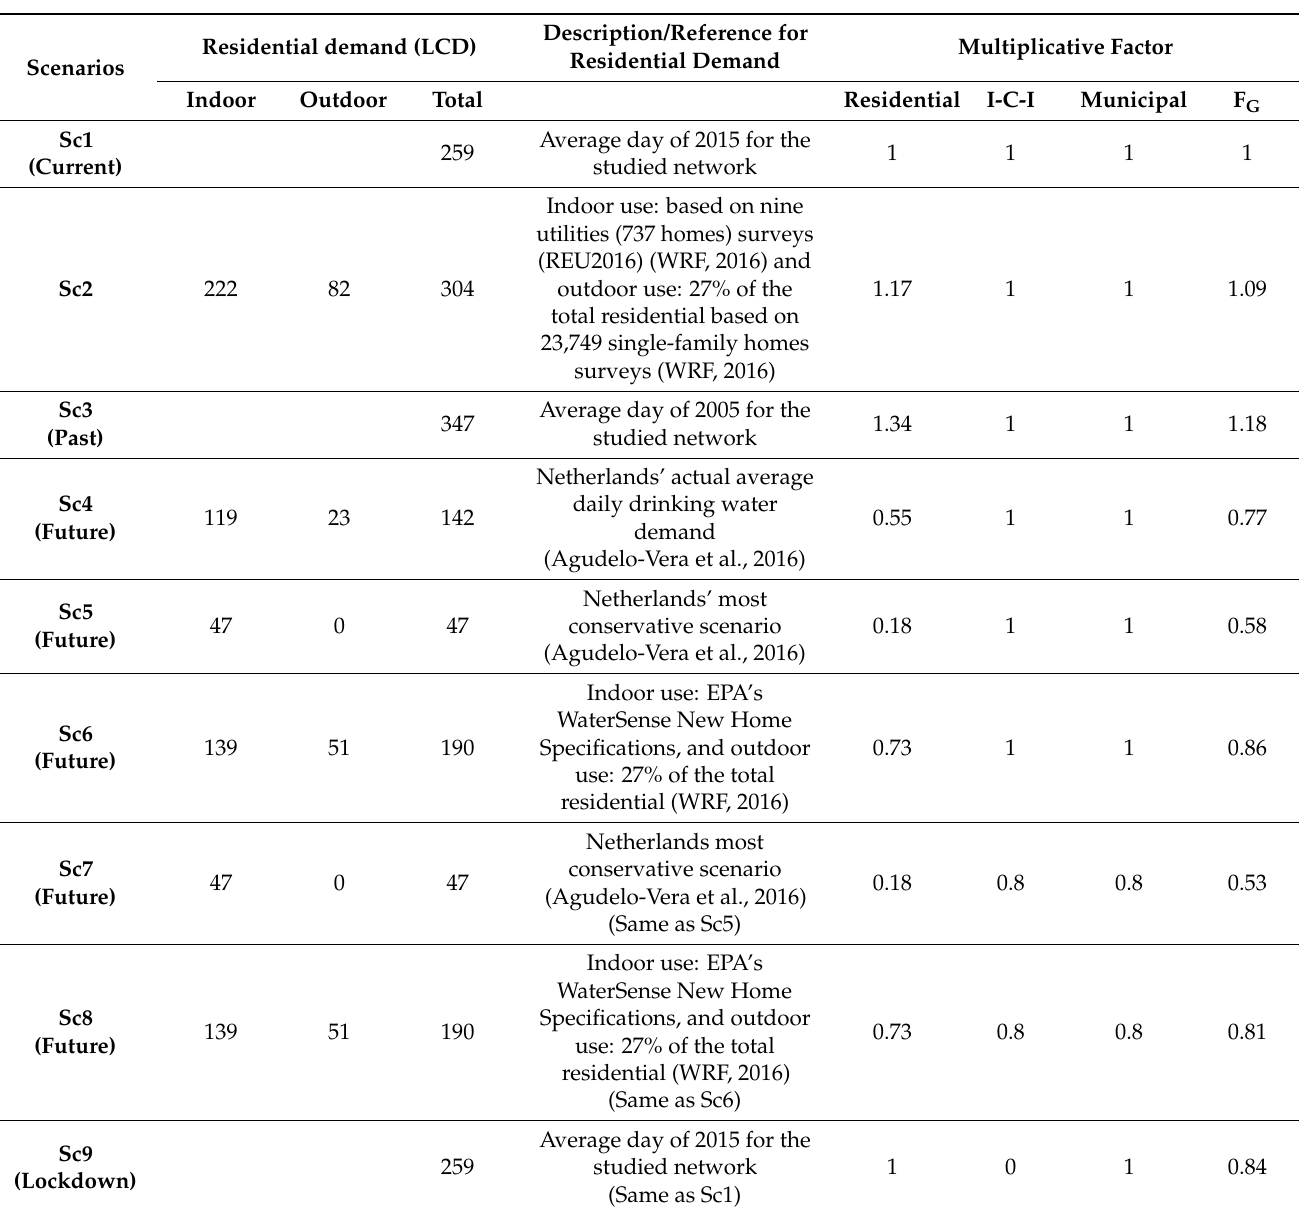
Table 1. Residential demand in liters per capita per day (LCD), and the implemented multiplicative factors for different user types: residential, industrial–commercial–institutional (I-C-I), and municipal for nine water demand scenarios. The global multiplicative factor (F G ) is the ratio of the scenario total demand to the total network demand of